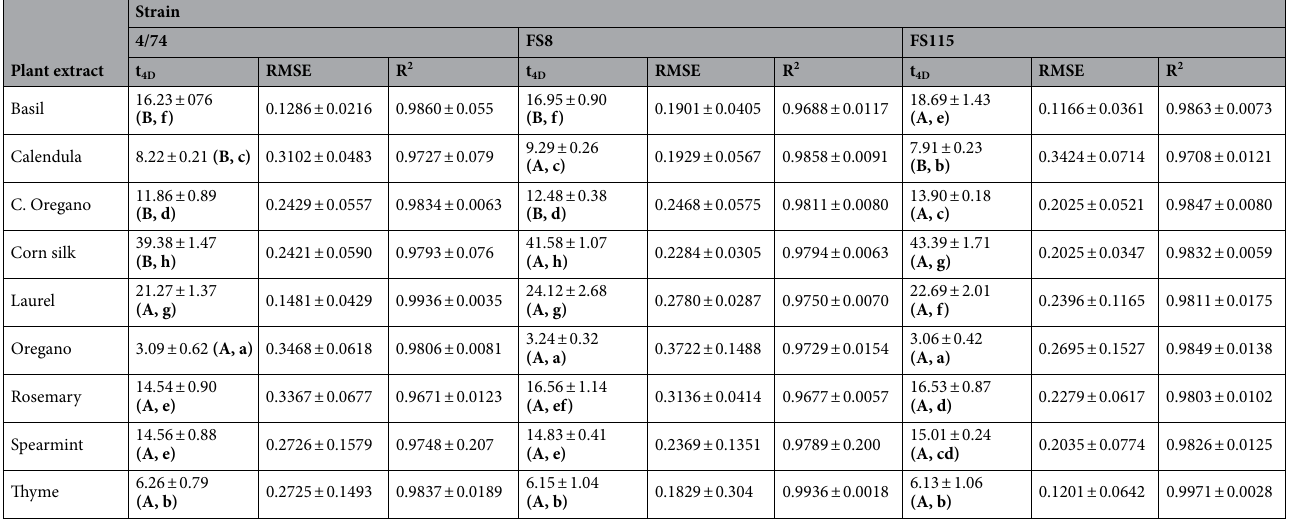
Table 2. In vitro inactivation kinetics (t 4D estimates) of S. Typhimurium 4/74, FS8 and FS115 in nine different plant aqueous extracts incubated at 4 °C. Extraction was carried out by hydro-distillation. t 4D ’s were calculated by fitting the log-transformed data to the Weibull model. Each value is a mean of at least 6 replicates (± standard deviation). Goodness of the fitting was evaluated using regression coefficient (R 2 ) and root-mean square error (RMSE). Different lowercase letters within the same column indicate statistical differences ( P < 0.05) for a single strain inoculated in different plant extracts according to Tukey’s HSD. Different capital letters within each row indicate statistical differences ( P < 0.05) among different strains inoculated to the same plant extract according to Tukey’s HSD.